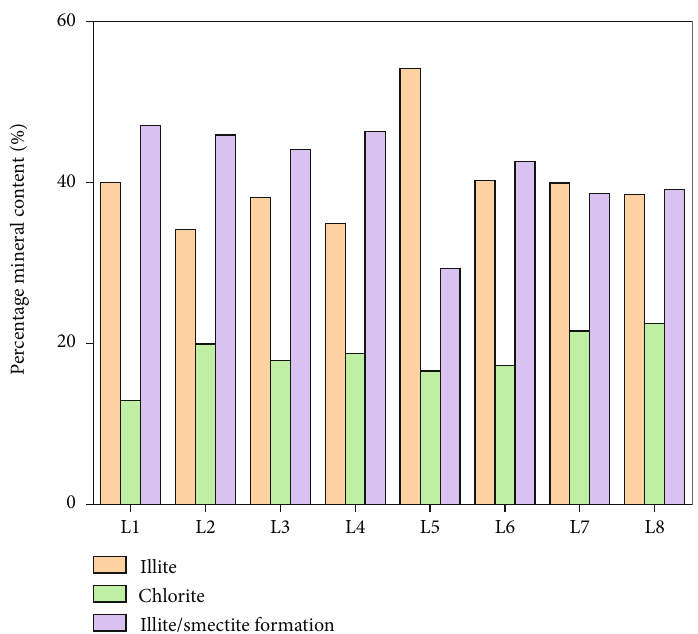
Figure 7: Histogram showing the content distribution of LF clay minerals in wells in the study area.